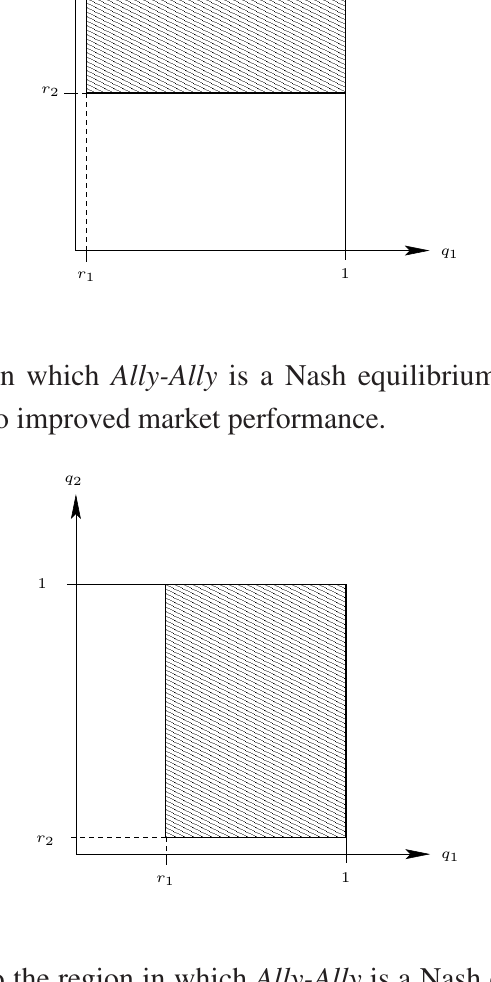
Figure 8. The change to the region in which Ally-Ally is a Nash equilibrium when Player I makes a unilateral commitment to improved market performance, which is then